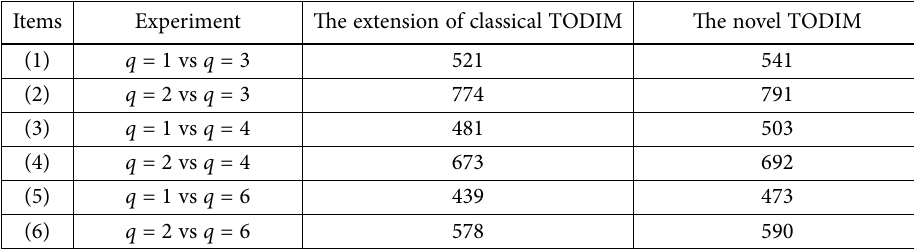
Note : The results are generated under the condition with the new distance and parameter p =